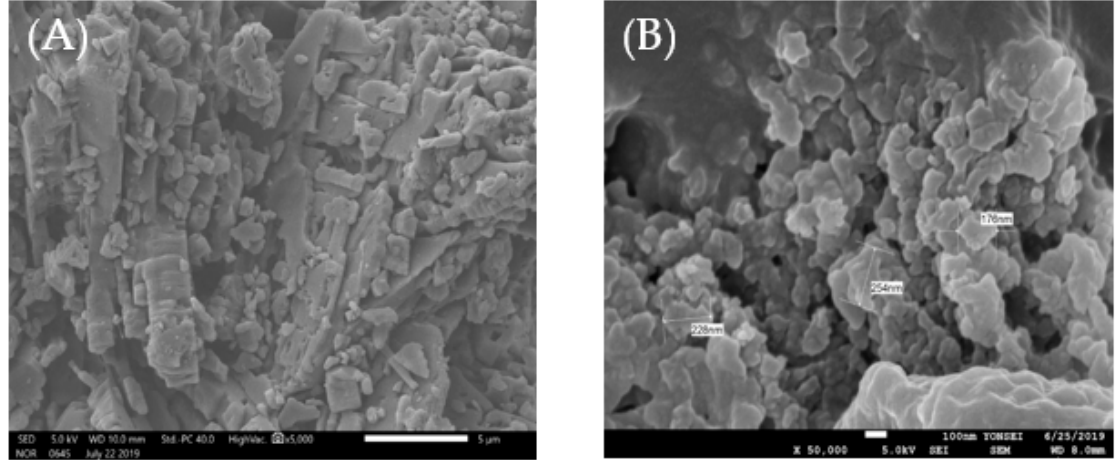
Figure 5. Scanning electron micrographs of ( A ) chrysin and ( B ) CEP-1:3.